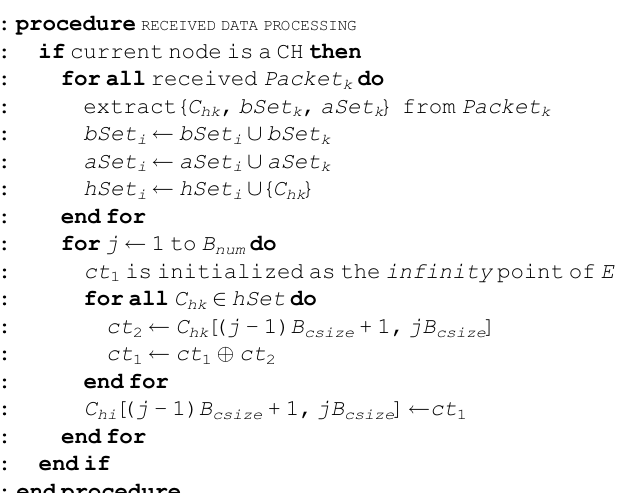
Algorithm 2 Operations on Client (Part II)